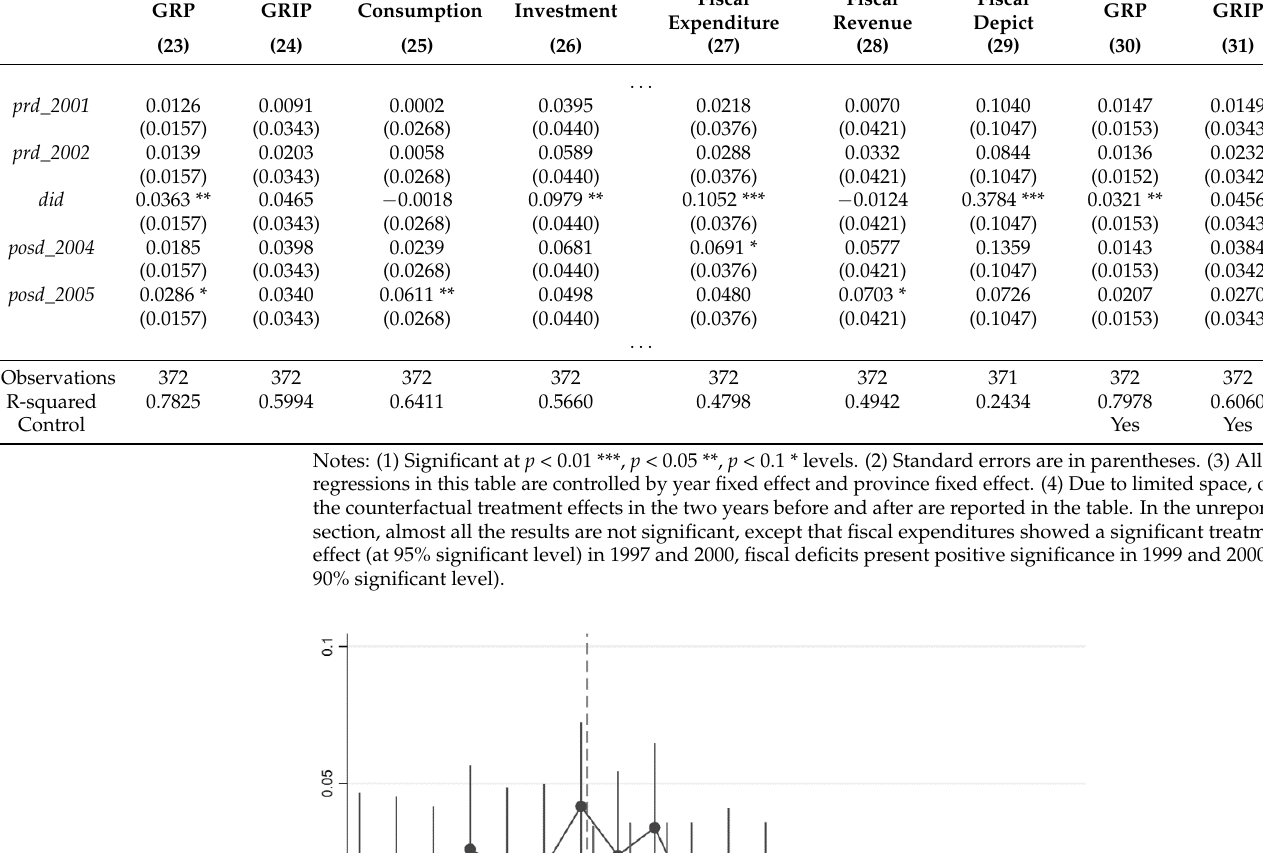
Table 4. Dynamic Mechanism Identification.